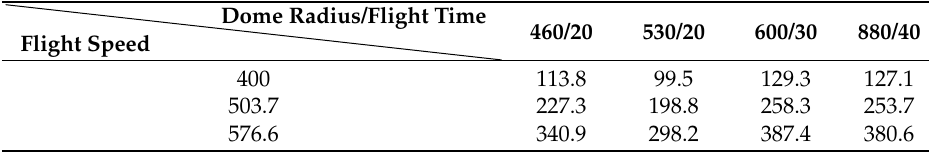
Table 2. Flight speed and stagnation temperature 1 . Dome Radius/Flight Time Flight Speed